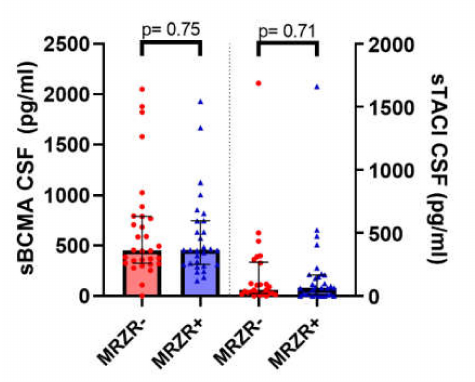
Figure 2. sBCMA: soluble B cell maturation antigen; CSF: cerebrospinal fluid; sTACI: soluble transmembrane activator and CAML interactor; MRZR-: primary progressive multiple sclerosis patients with no more than one positive MRZ antibody index; MRZR + : primary progressive multiple sclerosis patients with at least two positive MRZ antibody